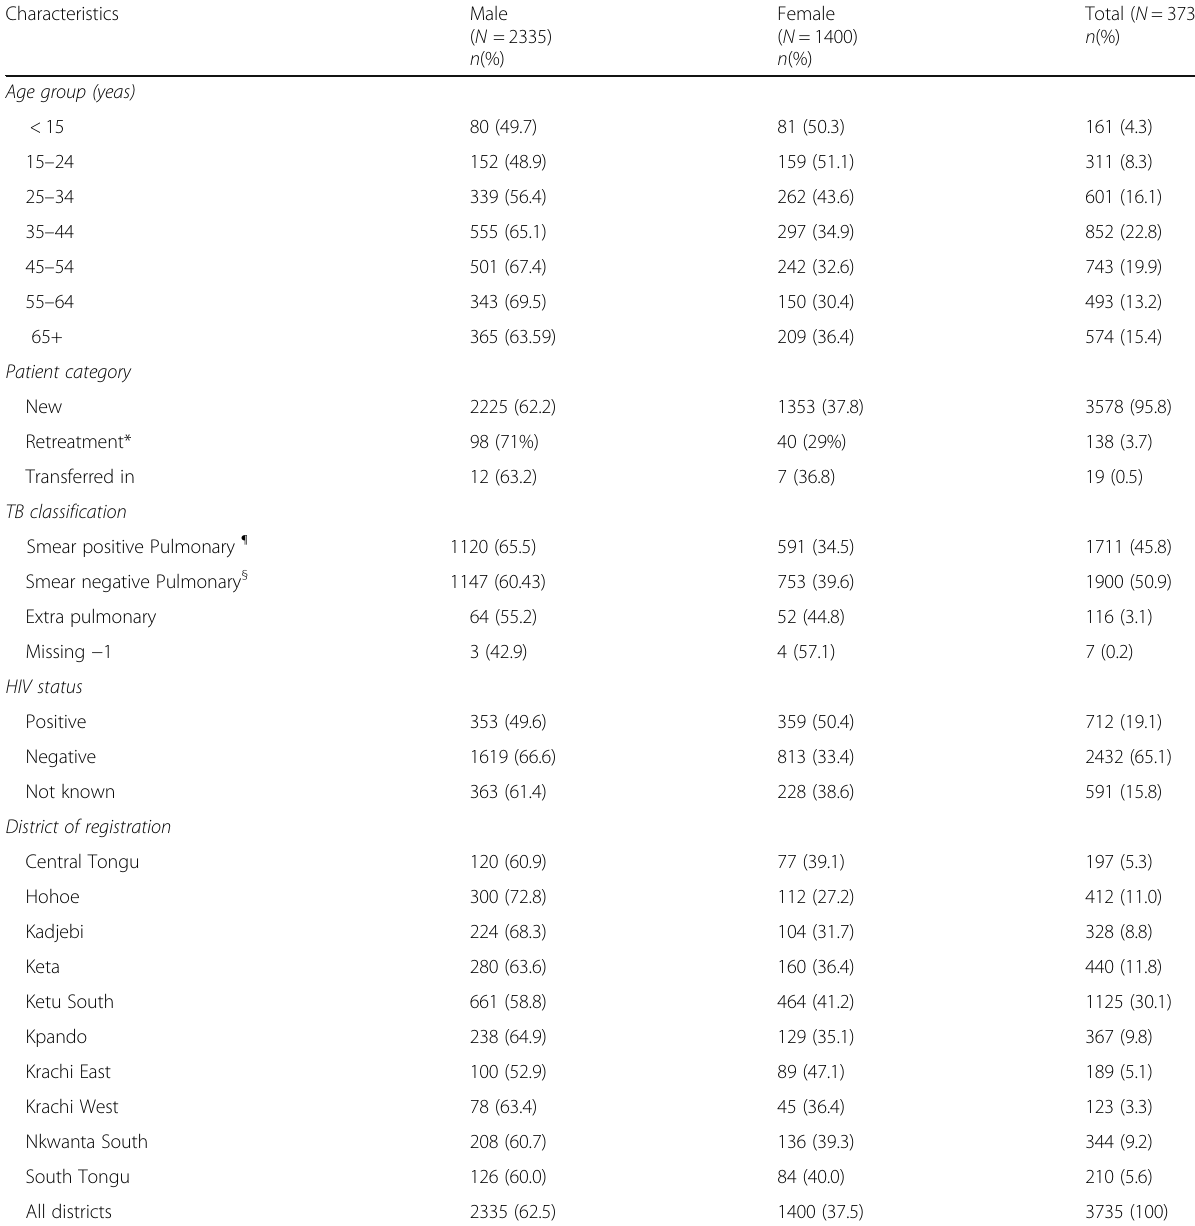
Table 1 General characteristics of Patients with TB in 10 districts of Volta region, Ghana (2013 – 2017)